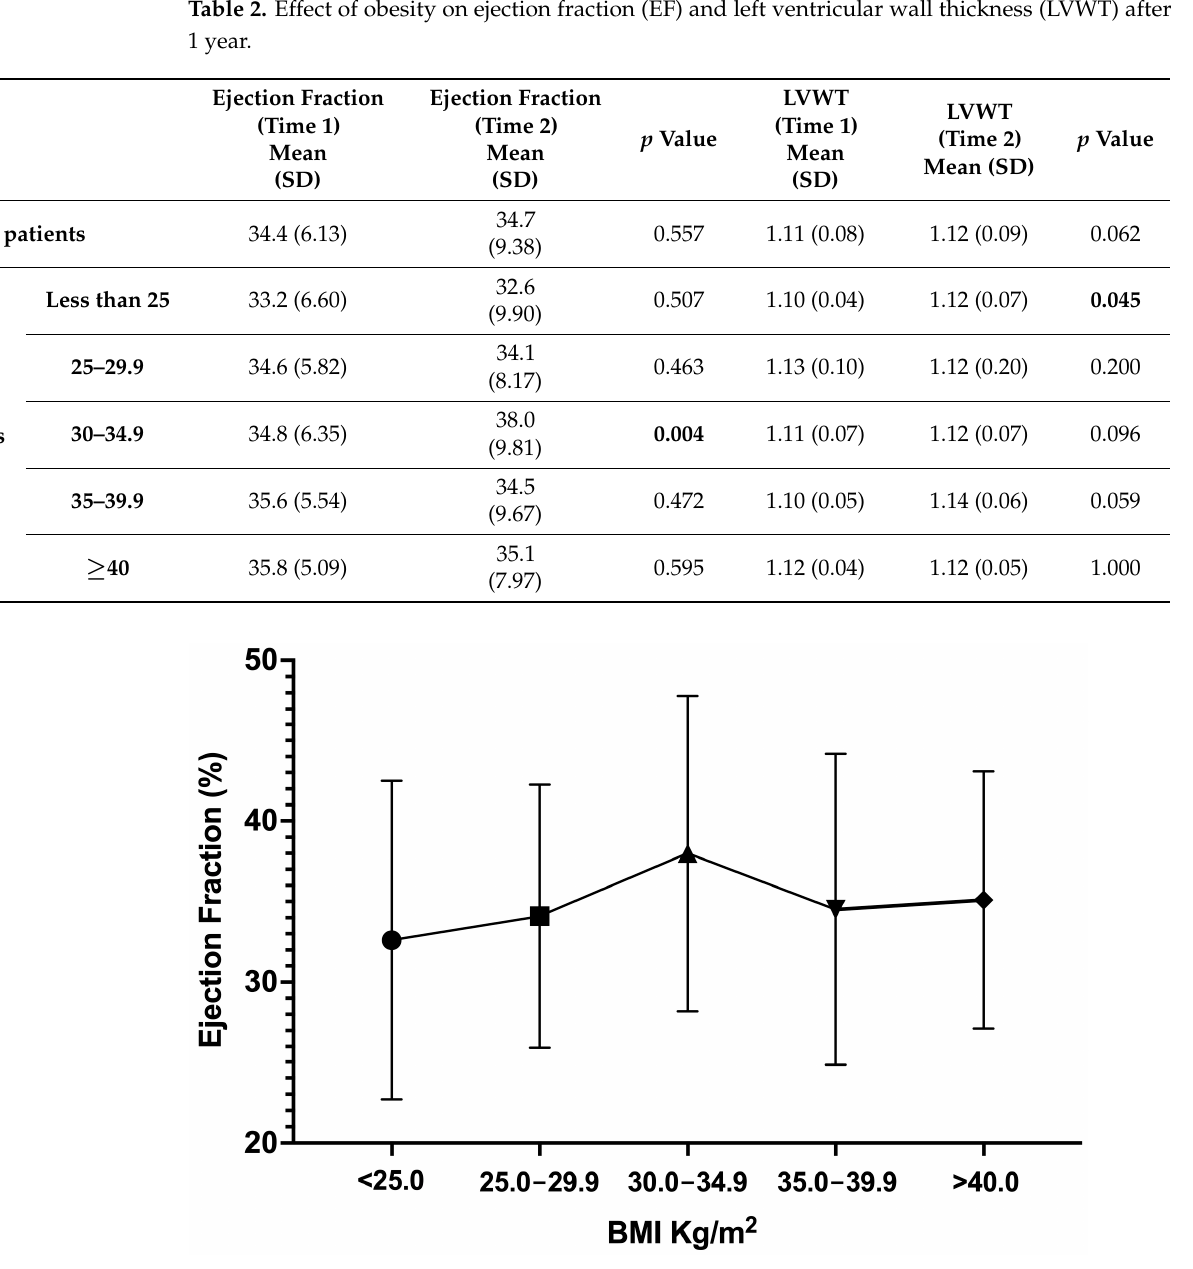
Figure 1. Representation of relationship between body mass index (BMI) categories and EF.